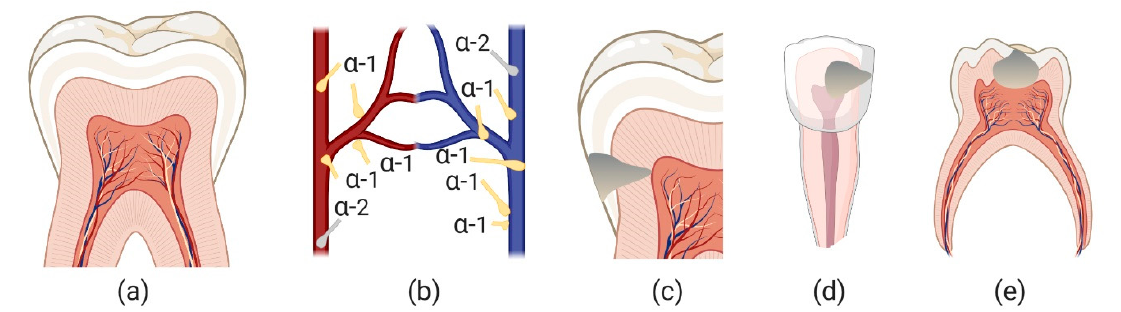
Figure 2. Tooth Anatomy and Pulpal Management. ( a ) A Cross-section of the pulp chamber with capillary plexus and post-capillary venules ( b ) sympathetic innervation is dominated by post synaptic α -1 adrenoreceptors associated with smooth muscles of arterioles and venules. A smaller population of the α -2 subtype is thought to exist ( c ) caries approaching pulp where mechanical exposure may require direct pulp capping ( d ) permanent tooth with immature roots and a caries exposure (or trauma exposure) that may require partial pulp removal for apexogenesis ( e ) large caries exposure on primary tooth requiring vital